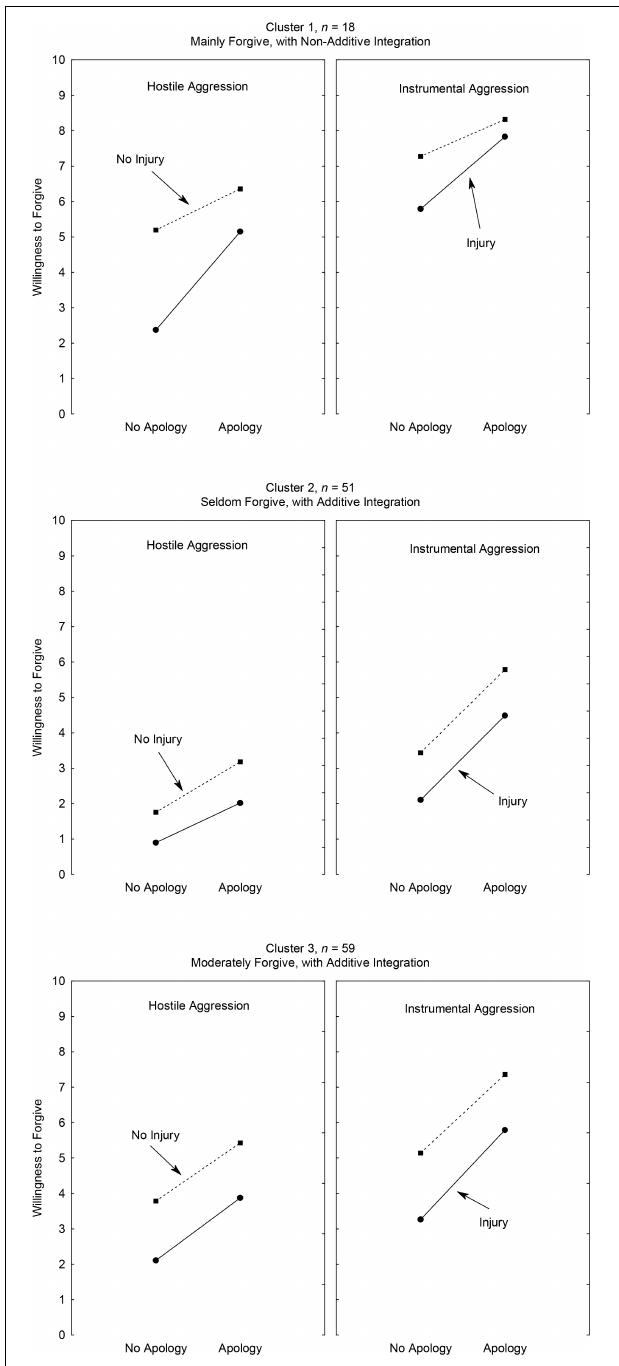
FIGURE 1 | Combined effects of intention, apology and consequence factors on judgments of forgiveness for each cluster. Hostile aggression involves intent to injure the opponent; Instrumental aggression involves intent to prevent the opponent from scoring.